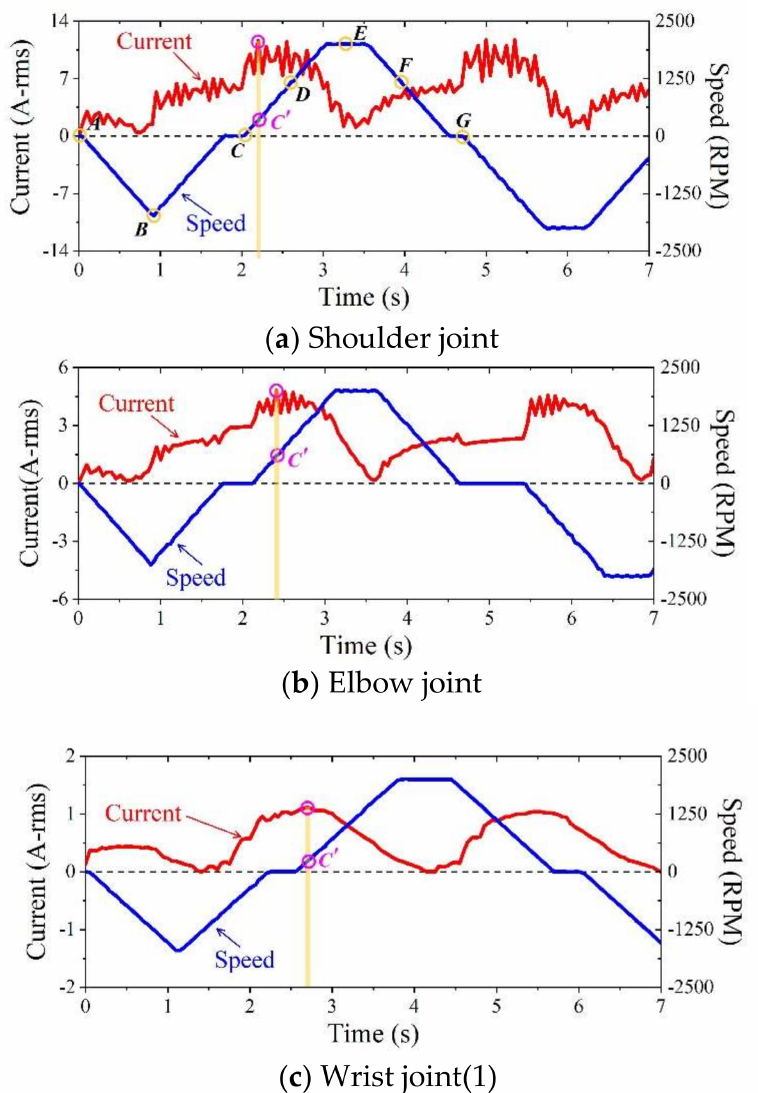
Figure 17. Input current and speed profile measured at the joint motor within each smart actuator: ( a ) Shoulder joint; ( b ) Elbow joint; and ( c ) Wrist